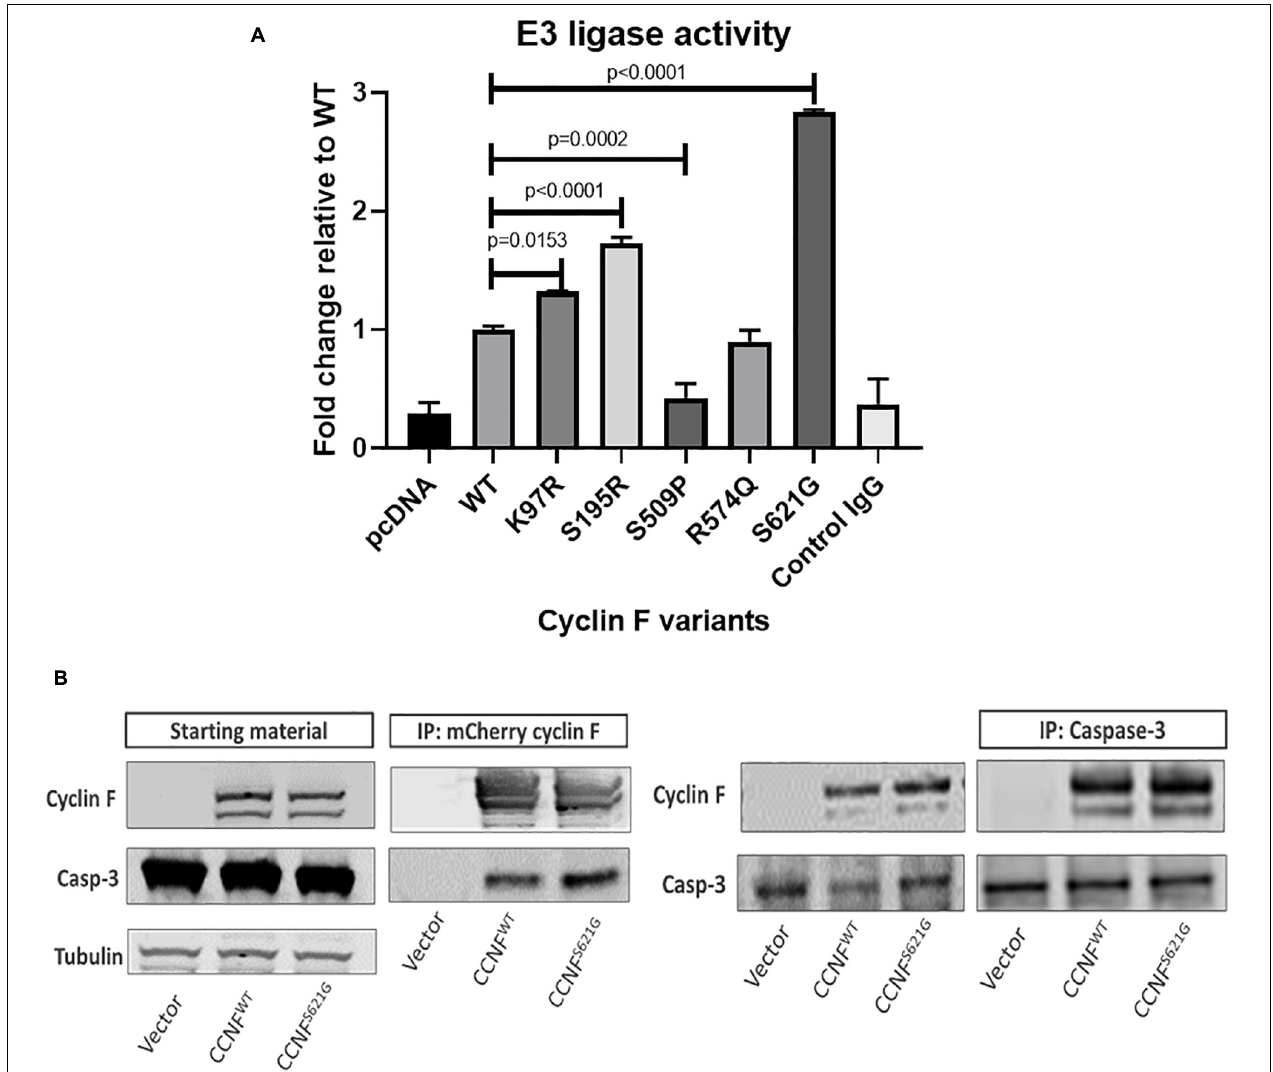
FIGURE 6 | (A) Lys48-ubiquitylation E3 ligase activity assay of immunoprecipitated cyclin F from cells expressing cyclin F wild-type, K97R, S195R, S509P, R574Q, and S621G. (B) Cyclin F interacts with caspase 3. HEK293 cells transfected with mCherry-cyclin F and immunoprecipitated (left blot) shows interaction with endogenous caspase-3. The reverse immunoprecipitation to enrich caspase-3 showed the same interaction with cyclin F (right